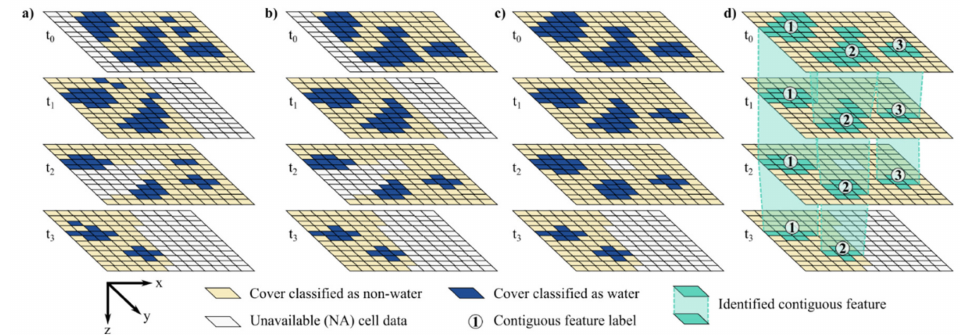
Figure 3. Illustration of how the binary classifications are morphologically described. ( a ) Classification raster data are stacked in chronological order (t 0 -t n ) in the z-direction. ( b ) Noise is removed by binary opening with a 5-cell structuring element. ( c ) To gap-fill missing data due to limited imaging extents or obscurations such as clouds, missing cell data are replaced with classified data from the next available day which match the same x-y position. ( d ) Features contiguous across space and time are identified from the gap-filled data and labeled sequentially with their ordinal